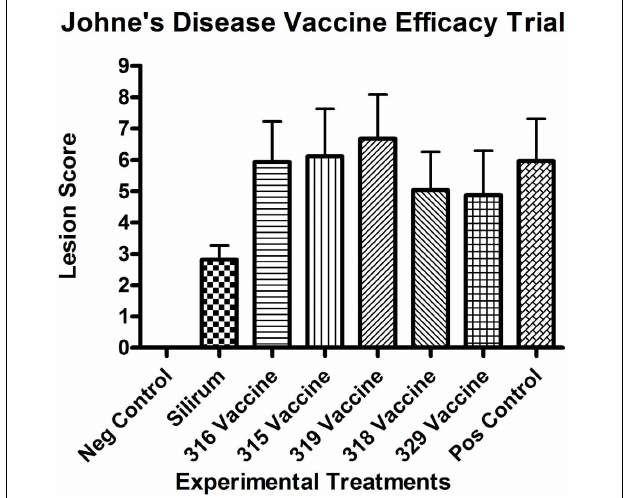
FIGURE 2 | Necropsy lesion scores for the challenged control and experimental groups at 13 months post-challenge. All negative controls (group 1, non-challenged kids) had lesion scores of 0. (Error bars represent standard error of the mean).